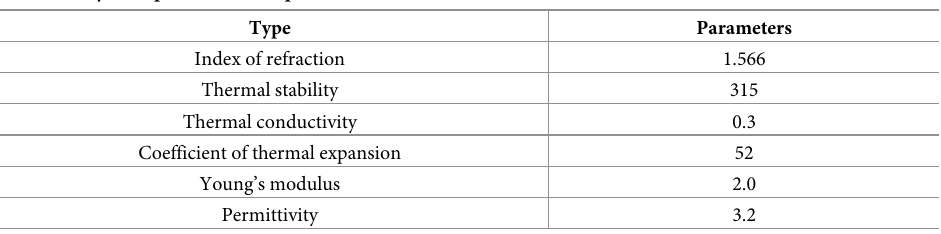
Table 2. Physical specifications of